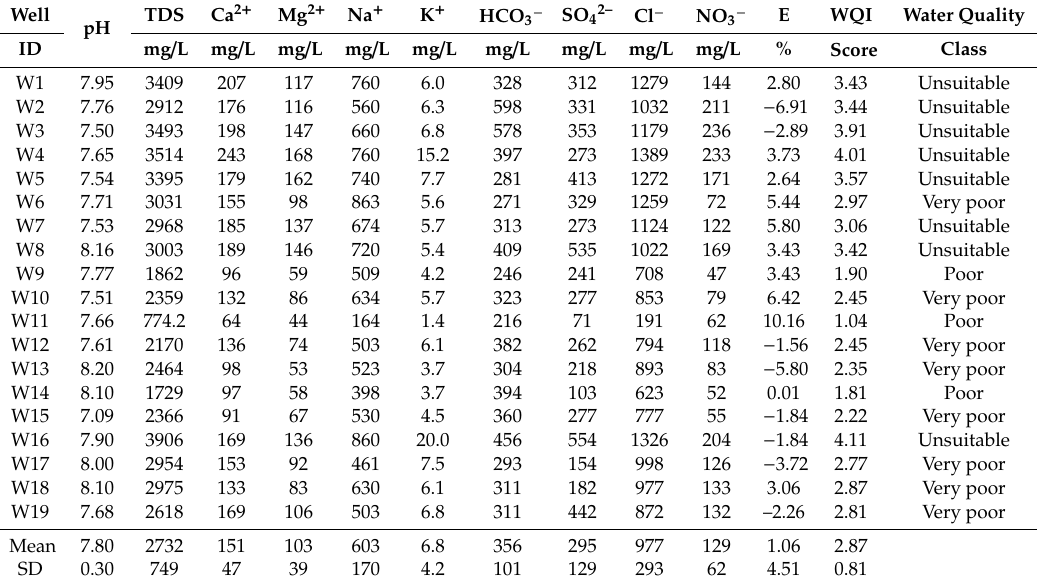
Table 4. Physio-chemical analysis of the groundwater samples taken in 2014; also given are the charge-balance error E , the WQI score, the water quality classification, and the mean and standard deviation